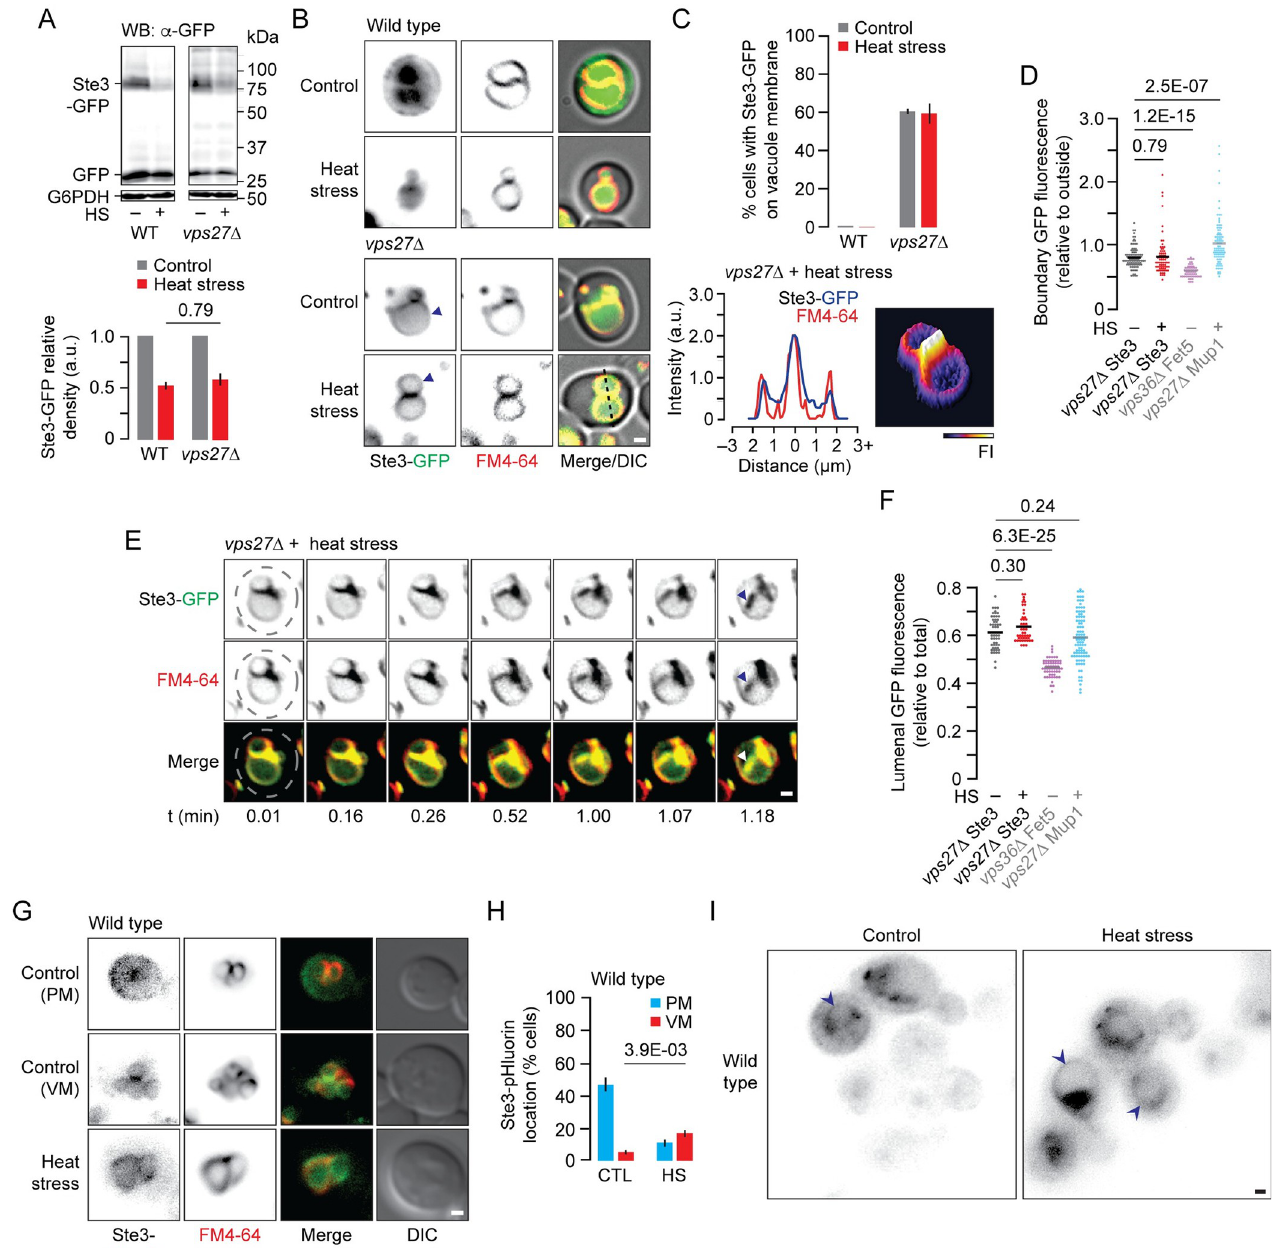
Fig 6. MVB and ILF pathways mediate degradation of Ste3. (A) Western blot analysis of whole cell lysates prepared from wild type (WT) or vps27 Δ cells expressing Ste3-GFP that were untreated or exposed to heat stress (HS). Blots were stained for GFP or G6PDH (load controls). Estimated molecular weights are shown. Intact Ste3-GFP band densities relative to control and normalized to corresponding G6PDH densities were calculated. n = 3 for each strain tested. (B) Fluorescence and DIC micrographs of live wild type or vps27 Δ cells stained with FM4-64 expressing Ste3-GFP before (control) or after heat stress (HS). Arrowheads indicate vacuole membranes. (C) Proportion of WT or vps27 Δ cells that show Ste3-GFP fluorescence on vacuole membranes before (control) or after heat stress. 885, 964 WT and 284, 166 vps27 Δ cells were analyzed before or after heat stress respectively. A 3-dimensional Mup1-GFP fluorescence intensity (FI) plot and line plots of GFP or FM4-64 for line shown in B indicate vacuole and boundary membrane localization. (D,F) Ste3-GFP fluorescence measured within boundary membranes (D) or lumen (F) of vacuoles within live vps27 Δ cells before (n = 93) or after heat stress (HS; n = 73). For comparison, boundary fluorescence of Fet5-GFP in vps36 Δ or Mup1-GFP in vps27 Δ cells after methionine addition are shown (see Fig 2C). (E) Snapshots from a time-lapse movie showing a homotypic vacuole fusion event within a live vps27 Δ cell stained with FM4-64 expressing Ste3-GFP after heat stress. Dotted line indicates cell perimeter; arrowhead indicates newly formed ILF. See S4 Video. (G) Fluorescence and DIC micrographs of live wild type cells stained with FM4-64 expressing Ste3-pHluorin before (control) or after heat stress. (H) Proportion of wild type cells that show Ste3-pHluorin fluorescence on the plasma membrane (PM) or vacuole membranes (VM) before (control, CTL; n = 195) or after heat stress (HS; n = 198). (I) Micrographs show Ste3-pHluorin location within cells;